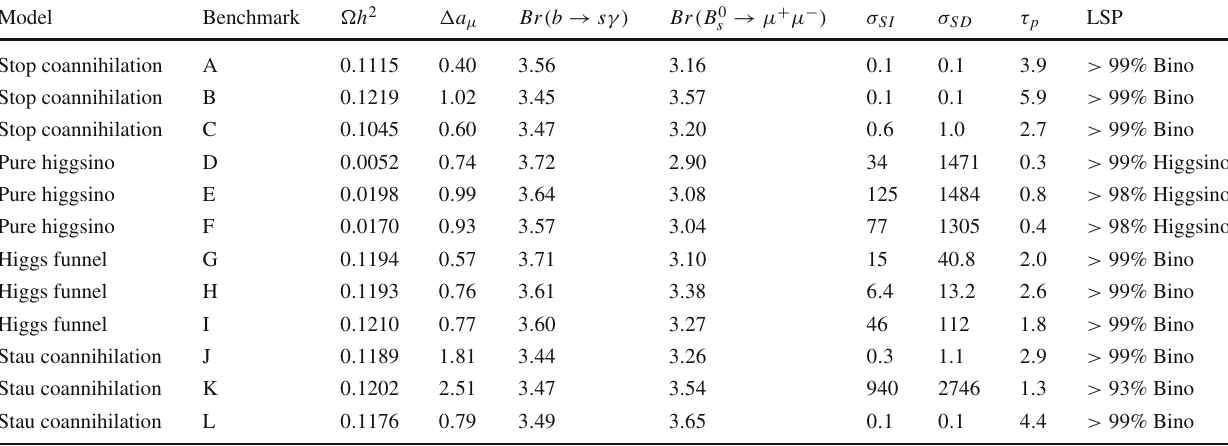
Table3 Relicdensity( (cid:9) h 2 ),raredecayprocesses( (cid:11) a μ , Br ( b → s γ) , Br ( B 0 s → μ + μ − ) , rescaled dark matter direct-detection cross sections ( σ SI , σ SD ), and p → e + π 0 proton decay rates ( τ p ) for the F - SU ( 5 ) general SUSY breaking soft terms of Table 1. The soft SUSY break- ing terms that generate each of these values can be identified by the alphabetical label. The σ SI and σ SD cross-sections have been rescaled